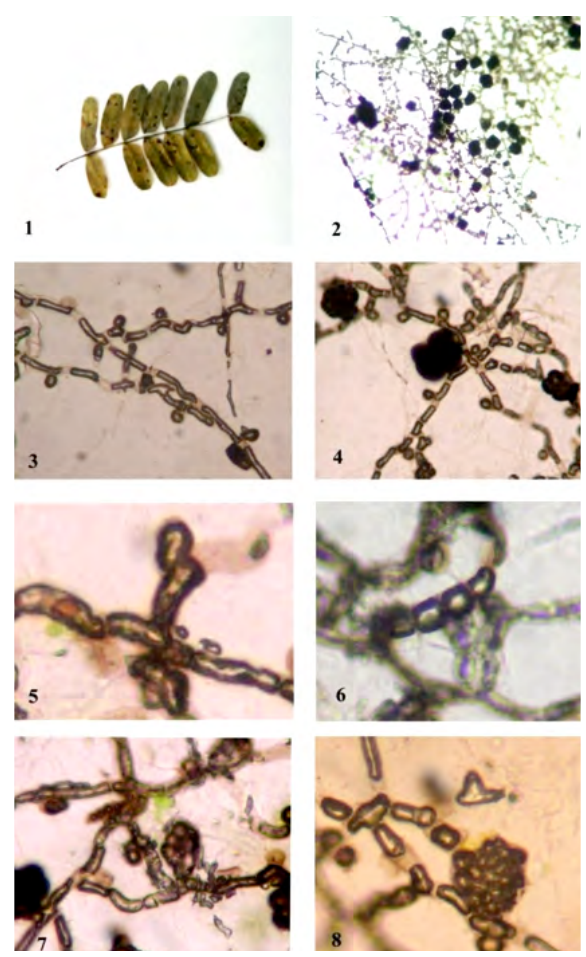
Image 17. a. Sarcinella tamarindi 1 - Infected leaves; 2 - Fungal colony; 3 - Appresoriate mycelium; 4 - Hyphae with sarciniform conidia; 5 - Conidiophore of Sarcinella ; 6 - Questieriella conidia; 7&8 - Developing